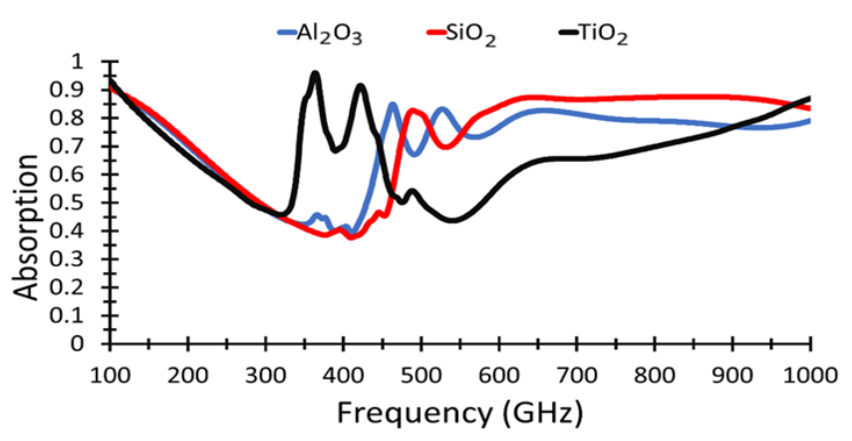
Figure 4. Absorption of the modified structure using different dielectric substrate materials.